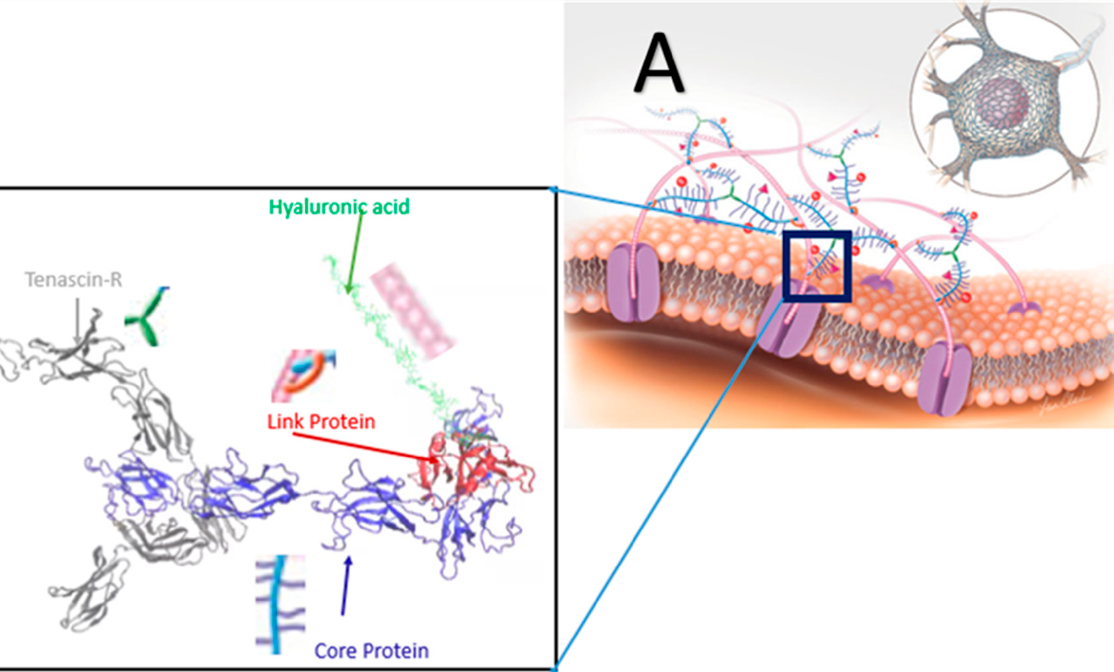
Figure 1. ( A ) Schematic illustration of the PNN structure. The overall macromolecular structure of the PNN is obtained by the specific arrangement and binding of the components [16]. A major component of the PNN is chondroitin sulfate proteoglycans (CSPGs) that include a core protein (CP) (blue) and several sugar chains (purple). Structurally, the CPs are bound to hyaluronic acid (HA) (pink). A set of link proteins (LPs) (orange) are also present in the PNN to stabilize the interaction between HA and CPs. Sema3A (pink pyramids) and Otx2 (red balls) are linked with the sugar chains of the CSPGs. Tenascin-Rs (green) are proteins in the PNN that are cross-linked with the CSPGs. ( B ) Docked PNN model structure.